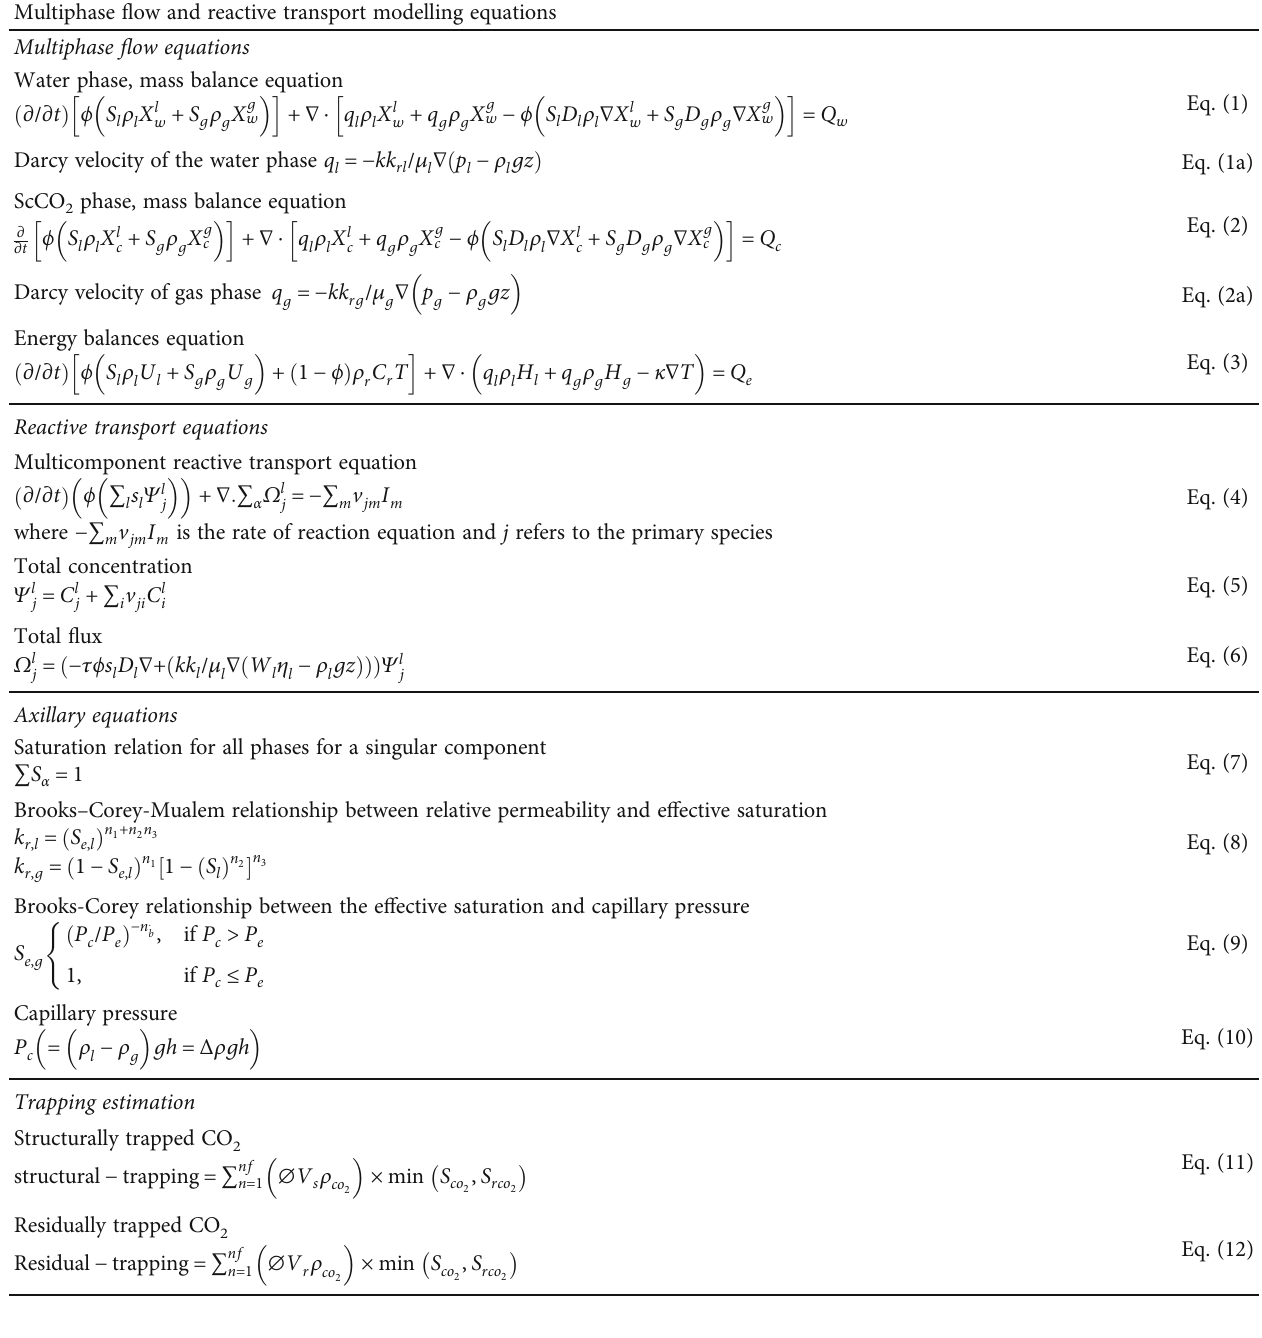
Table 1: Multiphase fl ow and reactive transport model for CO